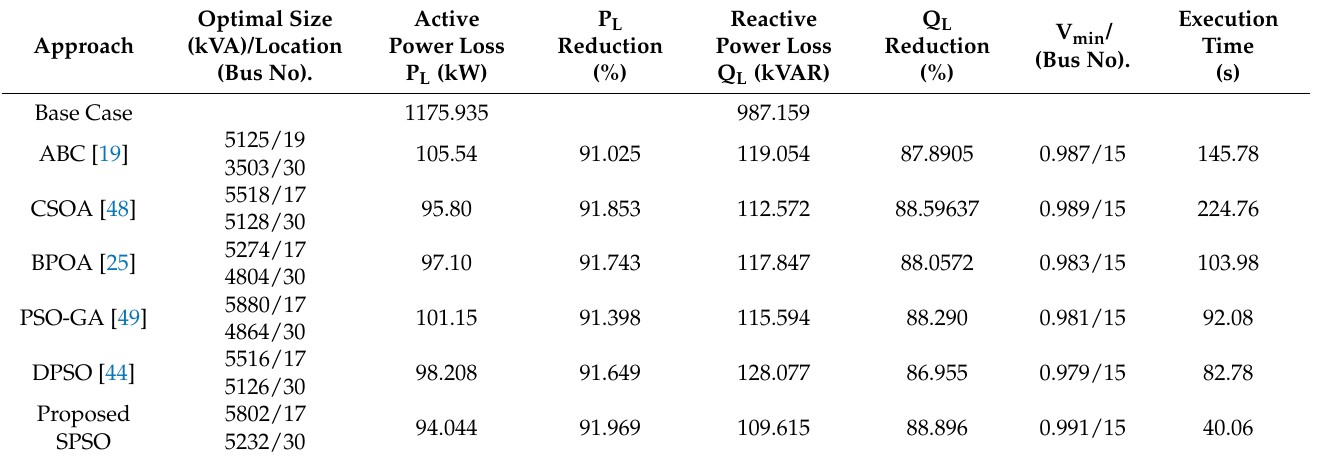
Table 6. Comparison of SPSO with other approaches in terms of different